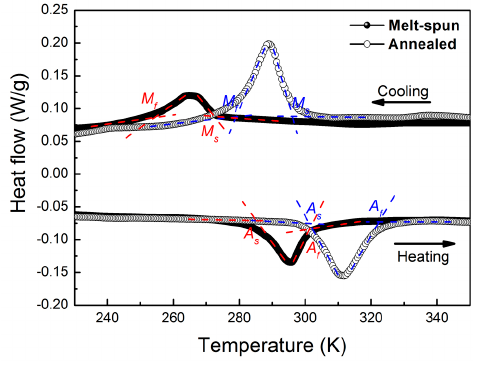
Figure 1. Differential scanning calorimetry (DSC) curves for melt-spun and annealed Mn 50 Ni 40.5 In 9.5 ribbons. Table 1. Martensitic transformation temperatures ( M s , M f , A s , A f ) for melt-spun and annealed Mn 50 Ni 40.5 In 9.5 ribbons.